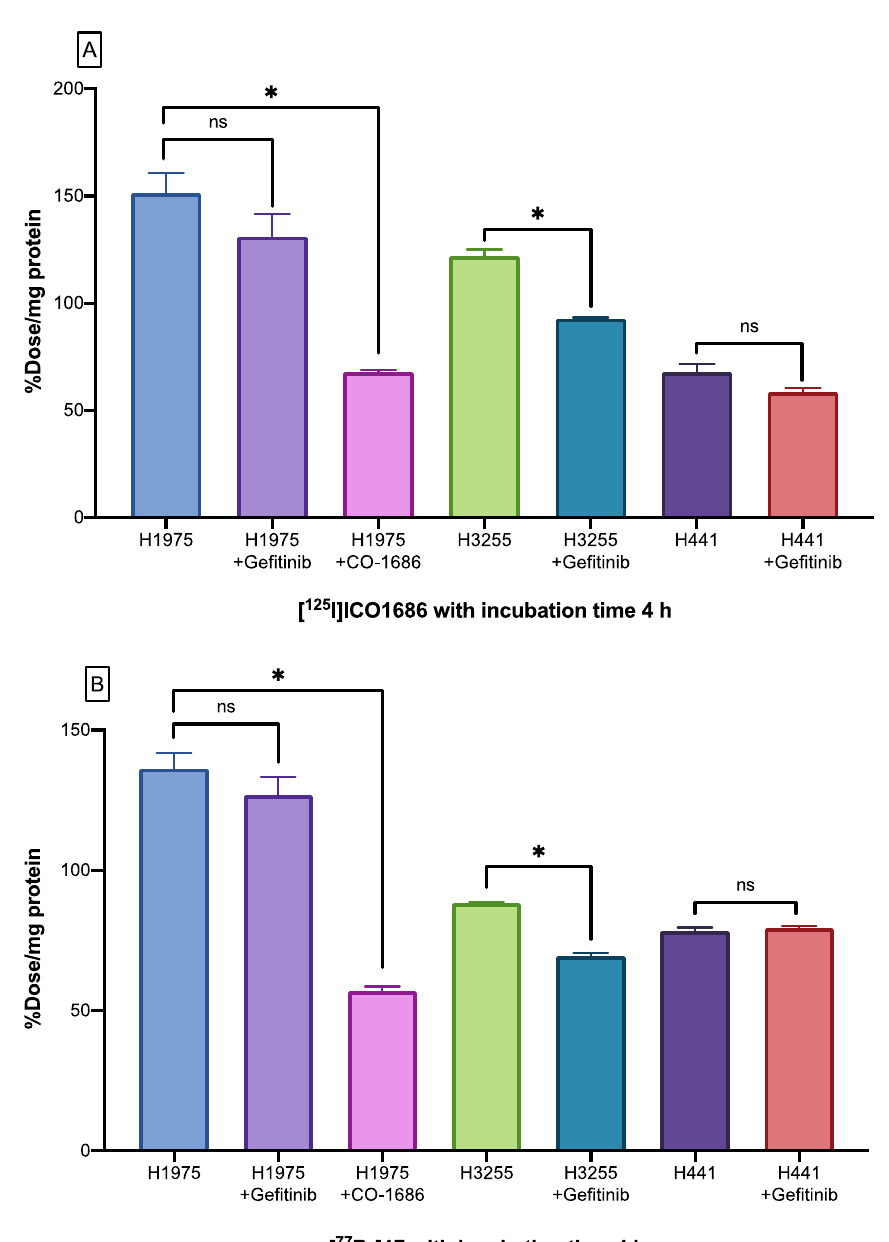
Figure 1. The cell uptake of ( A ) [ 125 I]ICO1686 and ( B ) [ 77 Br] 9 in H1975, H3255, and H441 cell